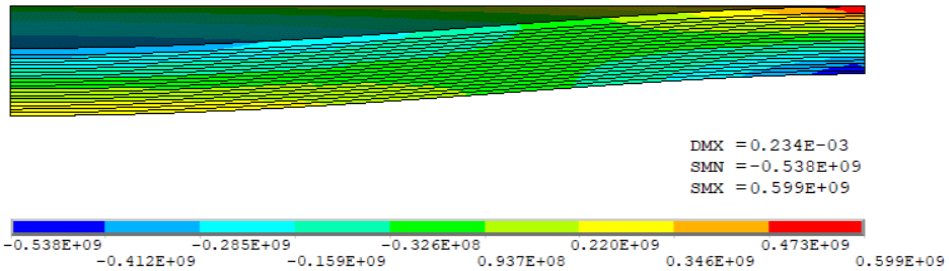
Figure 16. Radial stress field on the contour, multilayered plate, common FE.